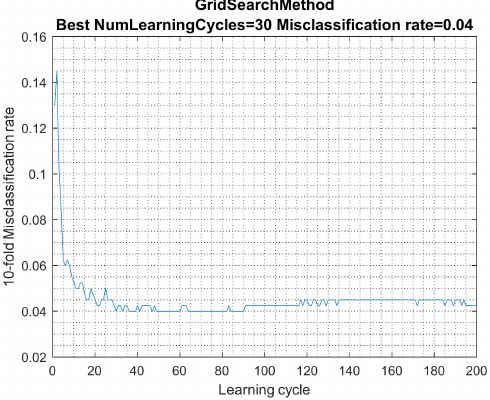
Figure 13. The results of the grid search method of bagging.